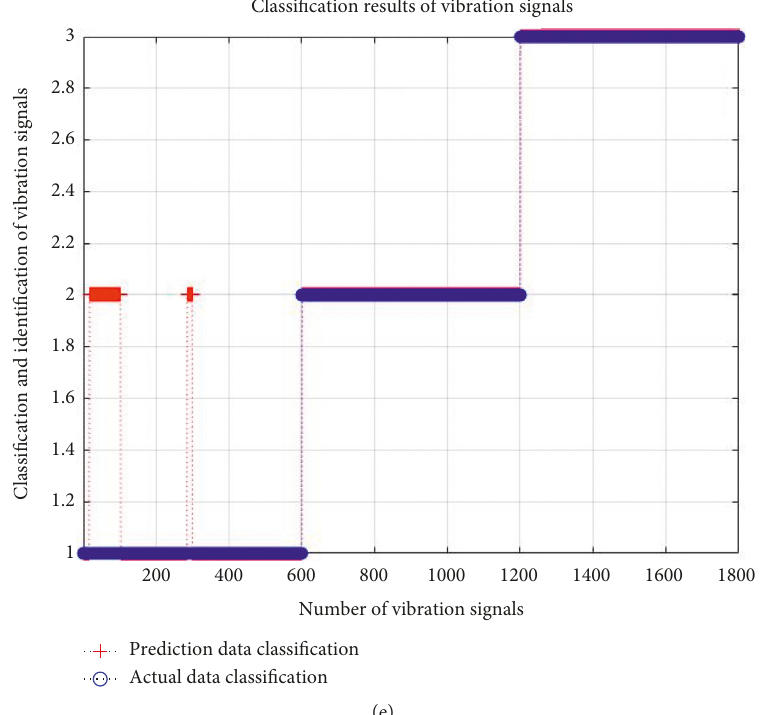
Figure 18: Identification rates of three units based on BA-BP neural network. (a) Generator; (b) inlet; (c) middle of the spiral casing; (d) tail of the spiral casing; (e) outlet. Table 7: Identification rates of three units based on four kinds of neural networks. Measuring point